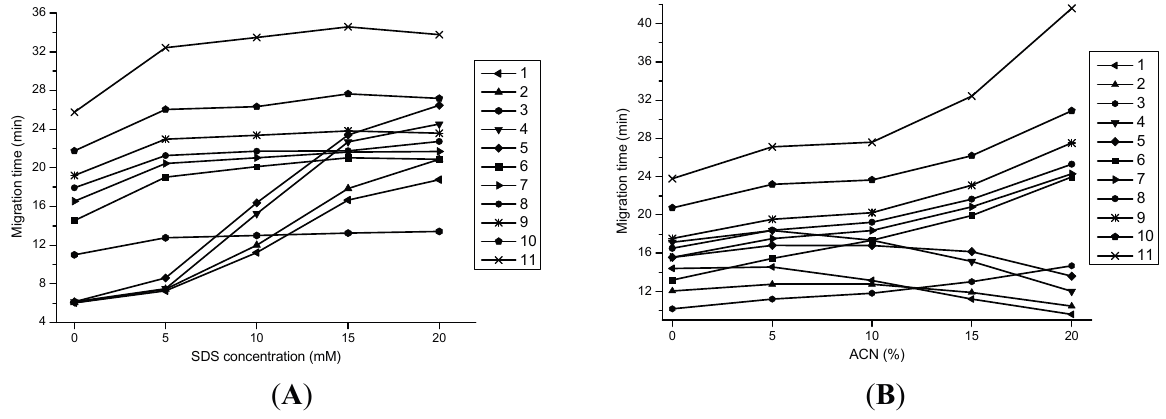
Figure 2. Effects of SDS and ACN concentration on migration behavior of the investigated analytes. Conditions: ( A ) 15 mM sodium tetraborate–5 mM β -CD–10 mM [bmim]BF 4 containing 15% ACN ( v/v ) at pH 9.8 with different concentrations of SDS; ( B ) 15